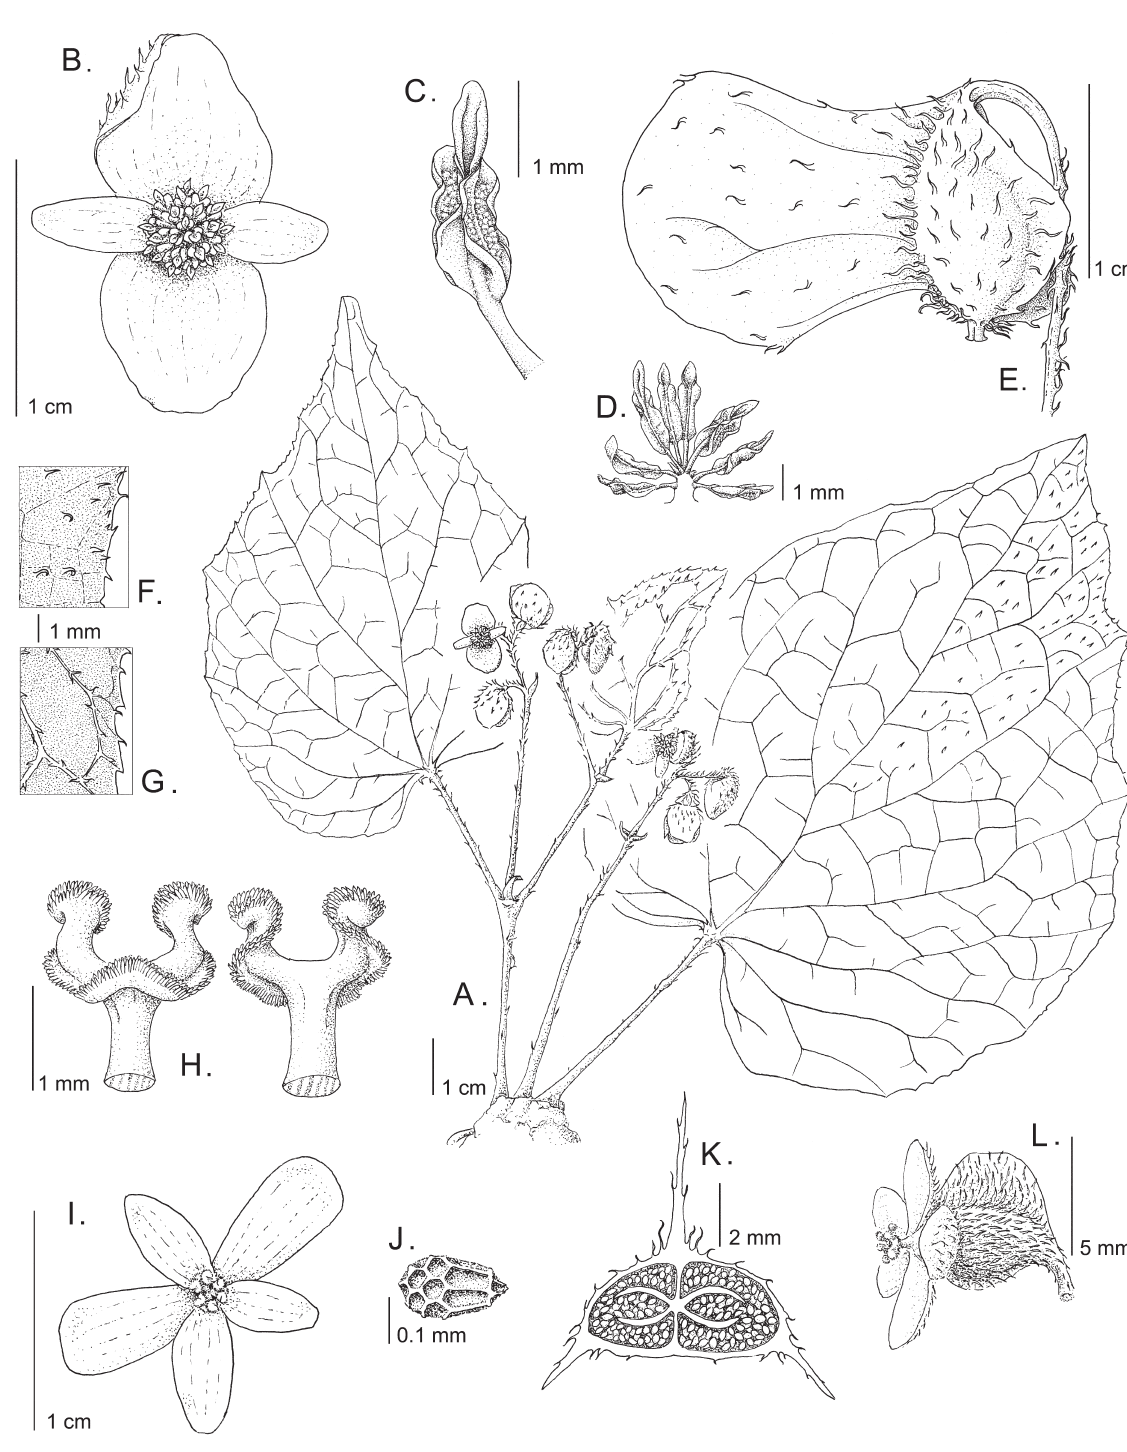
Fig. 15. Illustration of B. brevicaulis A.DC. A . Habit of plant. B . Male flower. C . Stamen. D . Selection of stamens. E . Mature fruit. F . Adaxial leaf surface. G . Abaxial leaf surface. H . Style. I . Female flower. J . Seed. K . Cross-section of fruit. L . Side view of female flower. Drawn by Rebecca Camfield. A–D, F–G from Chand 5819 ; E, J–K from Koelz 30496 ; H–I, L from Koelz 30887 ; all